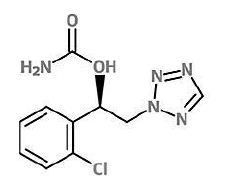
Figure 1. Chemical structure of cenobamate.